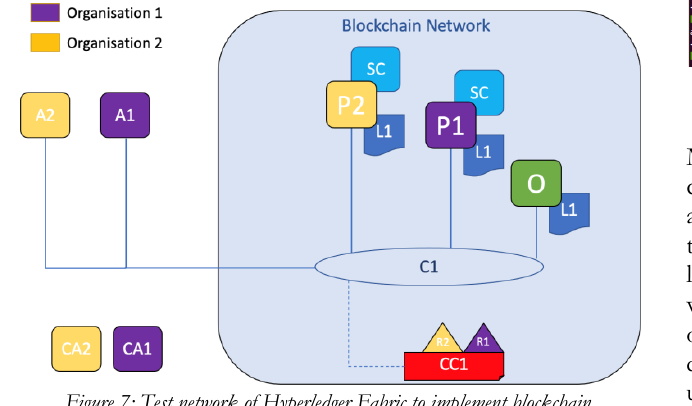
Figure 7: Test network of Hyperledger Fabric to implement blockchain architecture for proof of concept.